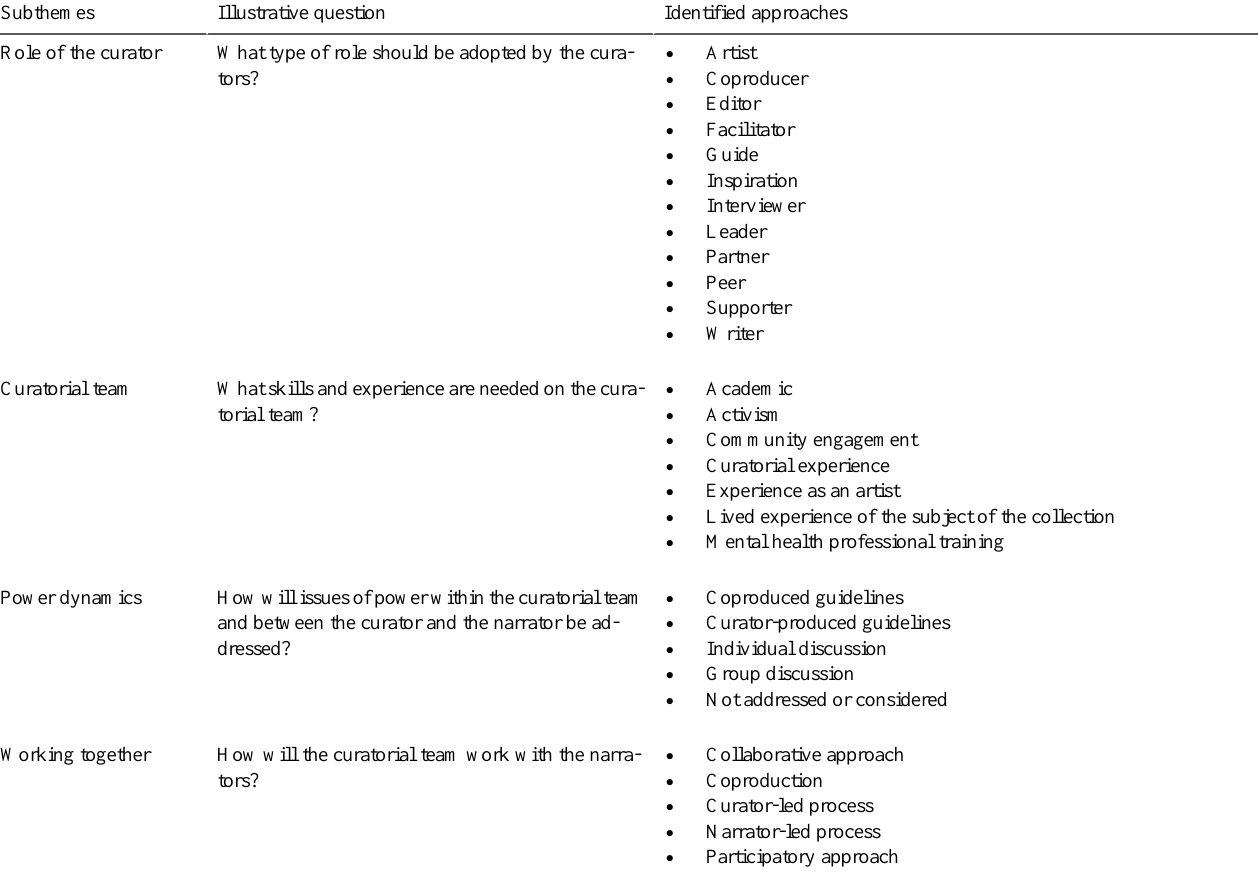
Table 5. Control and collaboration in the curation of